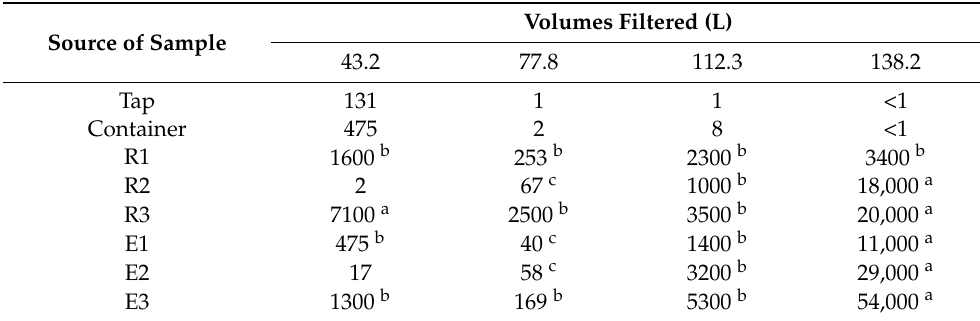
Table 3. Removal of TBC by filtration with fresh ODTMA granules (CFU/mL). Source of